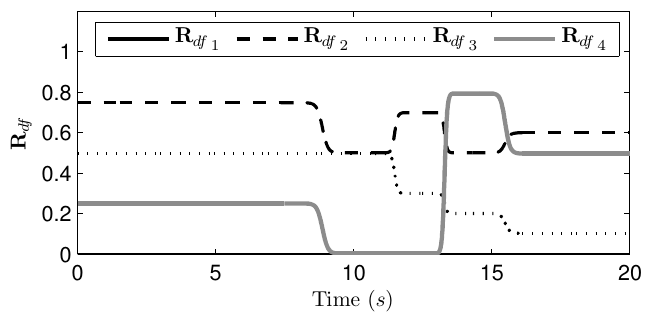
Figure 12. The four components of R df with respect to the